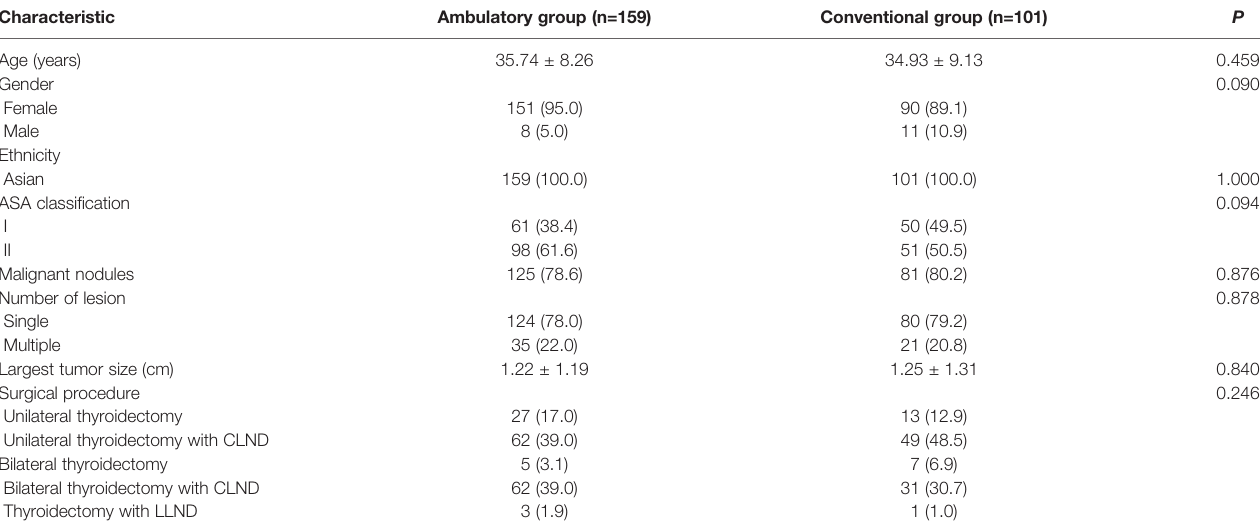
TABLE 1 | Patients and nodules